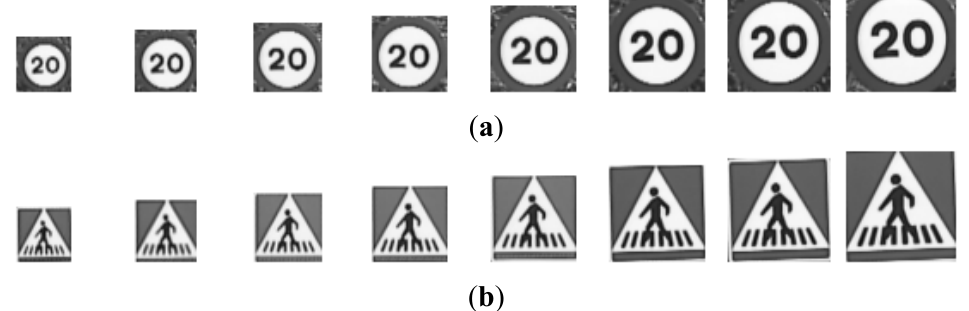
Figure 2. Examples of candidates: ( a ) Red road signs. ( b ) Blue road